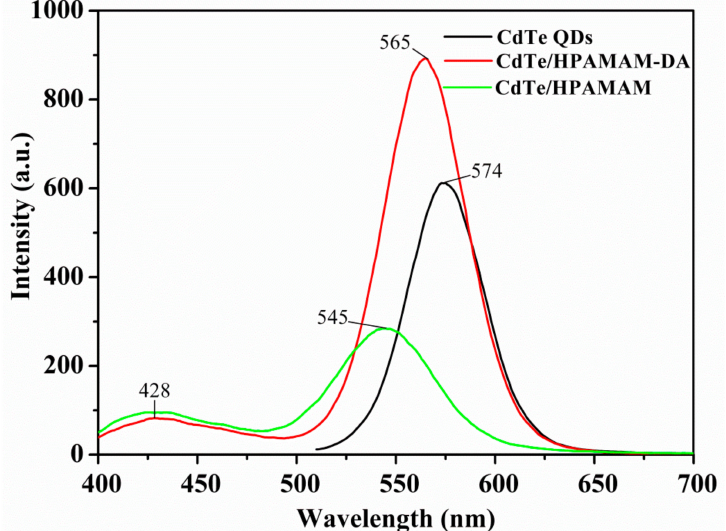
Figure 6. Photoluminescence (PL) spectra of aqueous CdTe QDs, CdTe QDs encapsulated by HPAMAM–DA in a chloroform phase and released CdTe QDs in the form of CdTe / HPAMAM nanocomposites, excited at 370